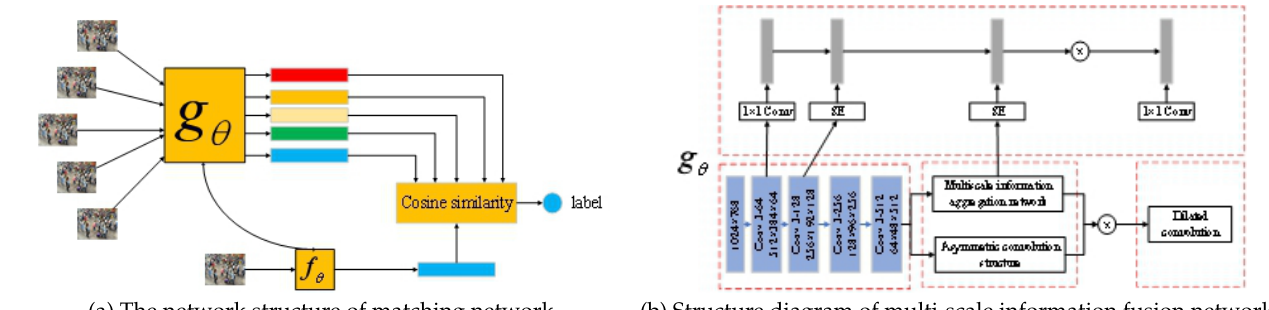
(b) Structure diagram of multi-scale information fusion network. Fig. 2. MSIFMN structure.